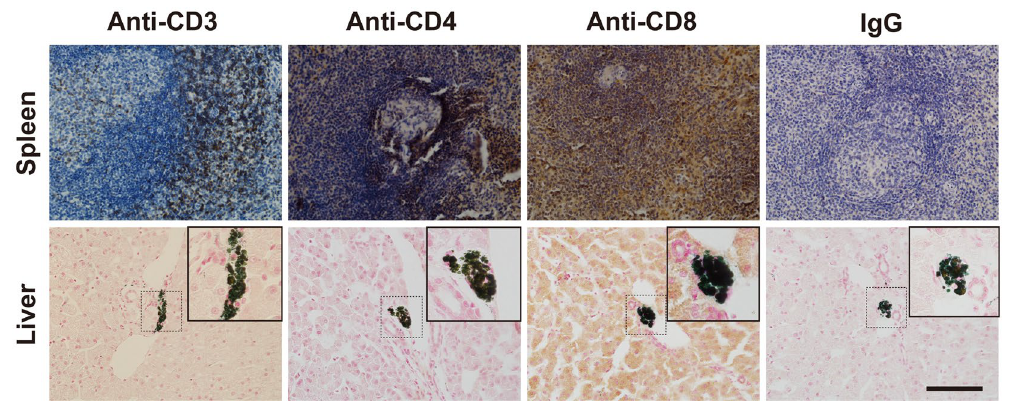
Figure 5. Immunogenicity of autografted ICCs in diabetic monkeys. Infiltration of T cells was not detected within and surrounding the transplanted ICCs on the monkey liver sections. T cells were identified by immunostaining with anti-CD3, anti-CD4 and anti-CD8 antibodies. The upper row represents the monkey spleen tissue sections that served as positive controls for CD3, CD4 and CD8. Cell nuclei were visualized using hematoxylin or nuclear fast red counterstain. Insets showed magnified views of indicated area. Scale bar represents 100 μ